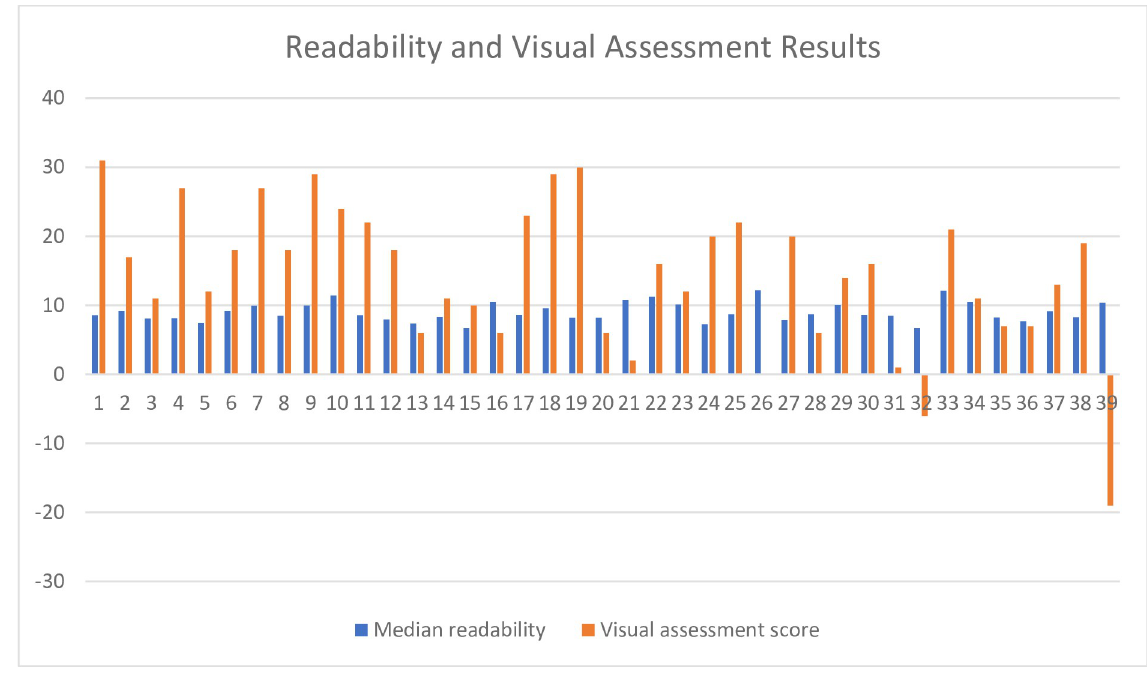
Fig 1. Readability and visual assessment of the 39 identified